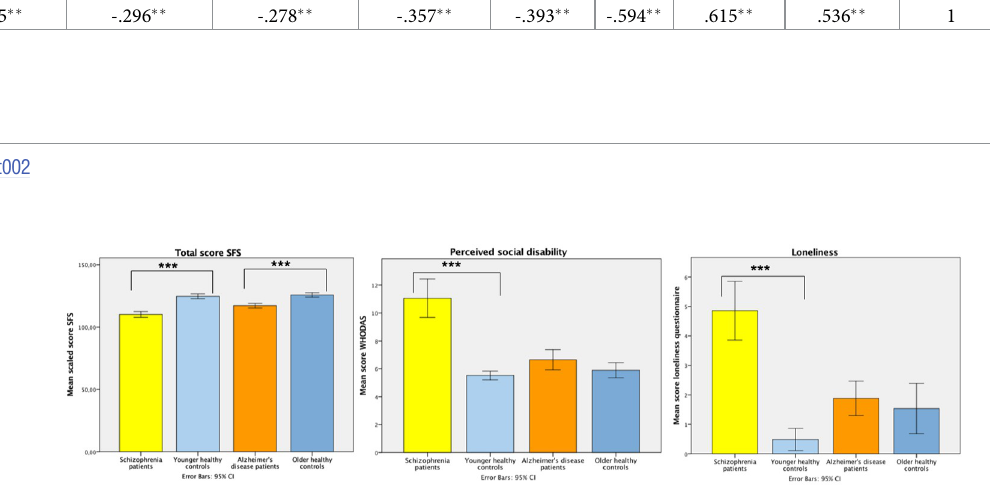
Fig 1. Unadjusted mean scores for total SFS, loneliness and perceived social disability across psychopathology. Error bars represent the standard error. Y axis depicts the different scores. � p-value < 0.05, �� p-value < 0.01, ��� p- value <